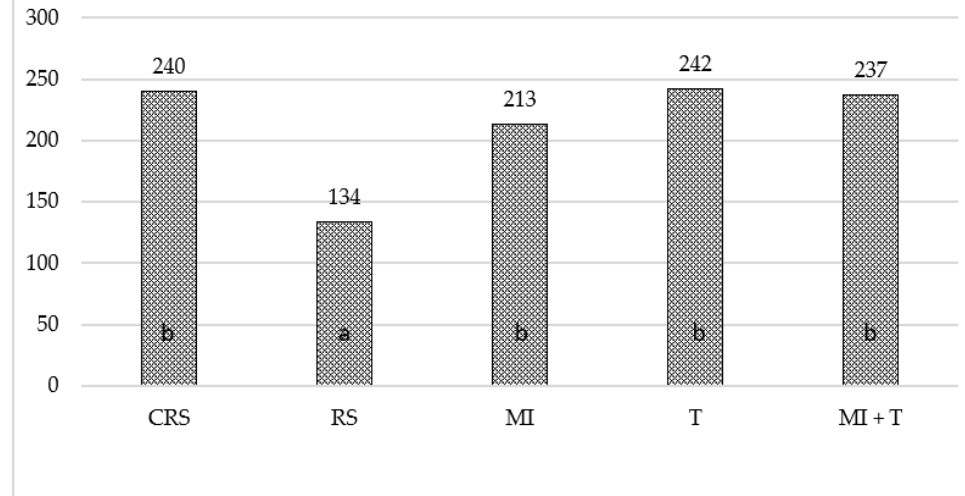
Figure 3. Weight of the roots of the apple trees (g) (CRS = crop rotation soil; RS = replanted soil; MI = mycorrhizal inoculum; T = Trichoderma; MI + T = mycorrhizal inoculum + Trichoderma ). Means marked with the same letters do not differ significantly at α = 0.05.